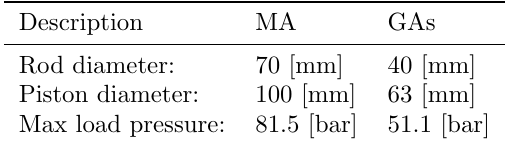
Table 4: Selected cylinder dimensions and max induced load